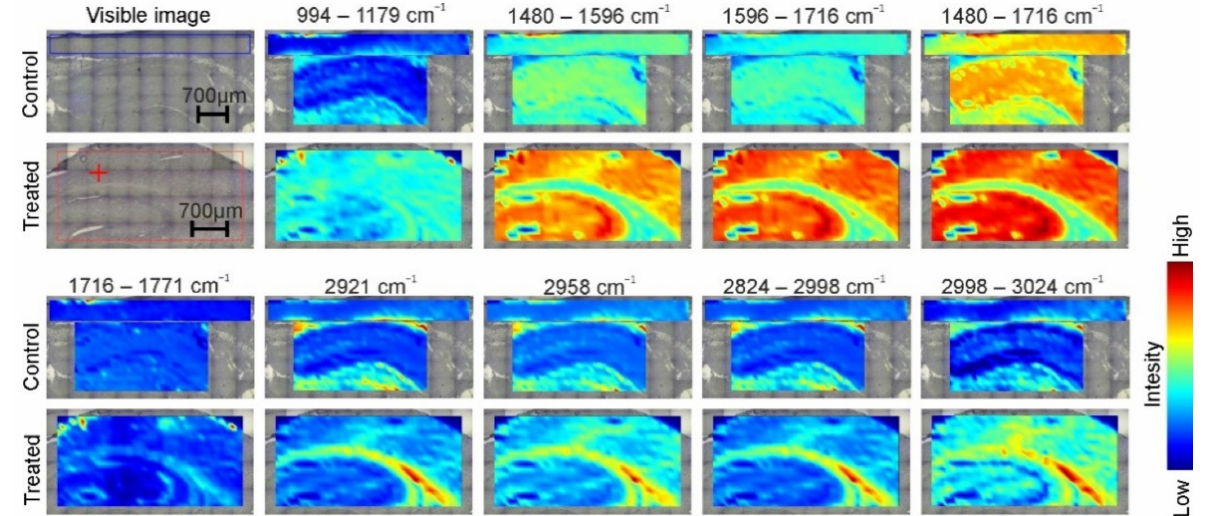
Figure 5. FT-IR images of cortex and hippocampus of the control and anticonvulsant-treated sample. The spatial distributions of selected bands lipids and amides are presented. The bands assignment are described in Table